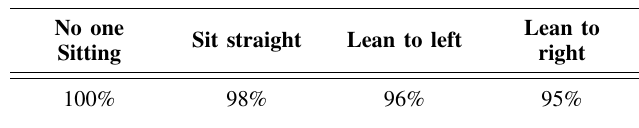
W HEELCHAIR USER ’ S POSTURE RECOGNITION ACCURACY